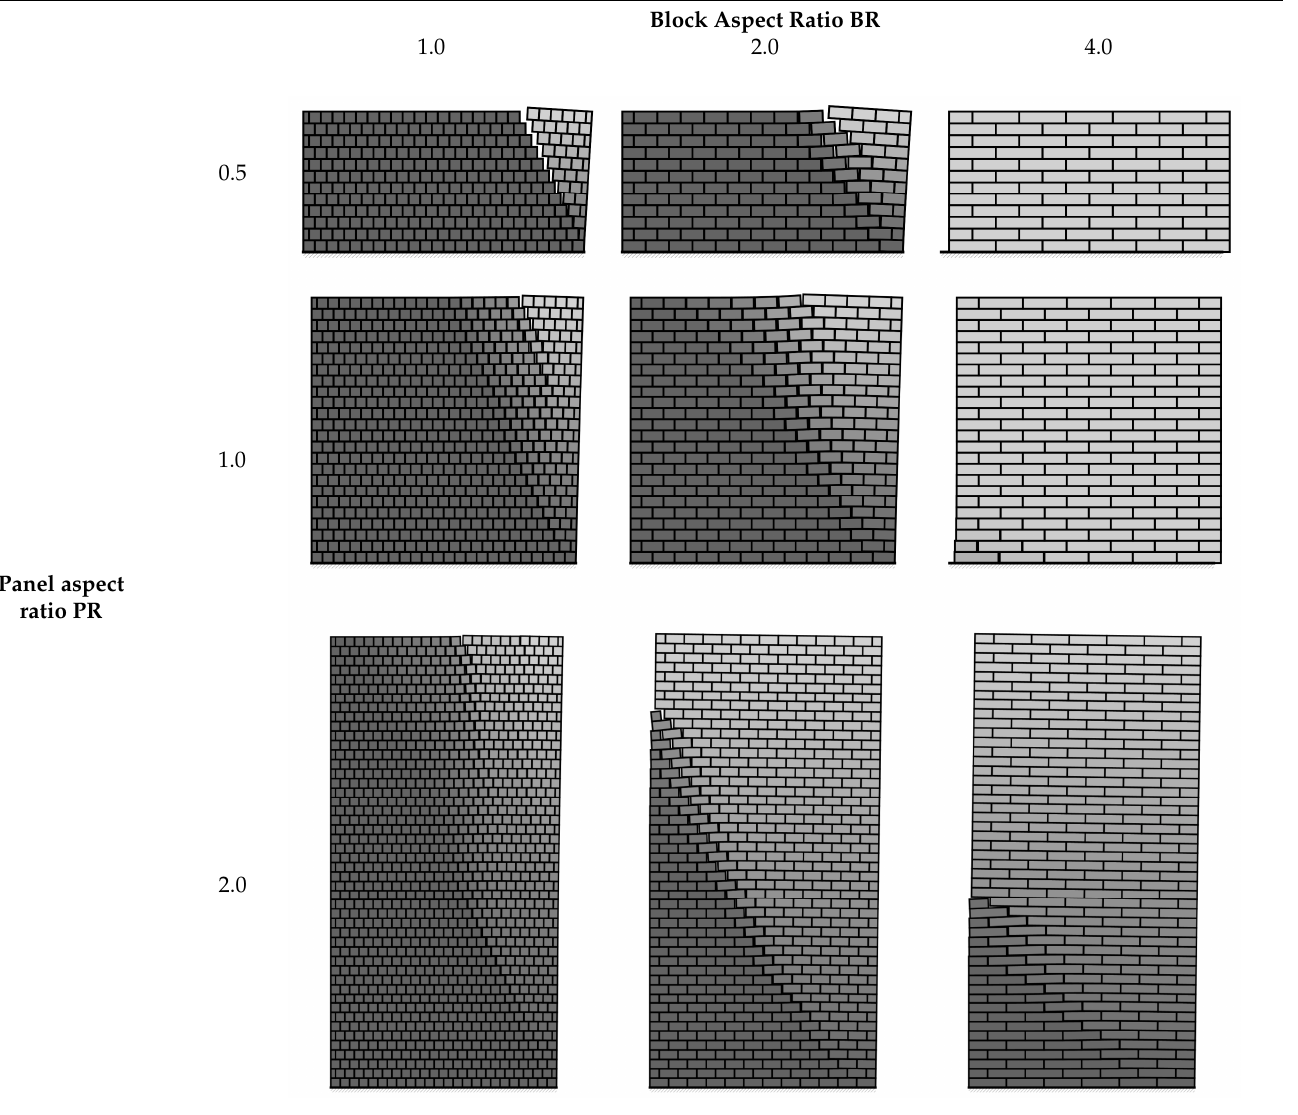
Table A1. Failure Mechanisms for Running Bond with µ = 0.5.